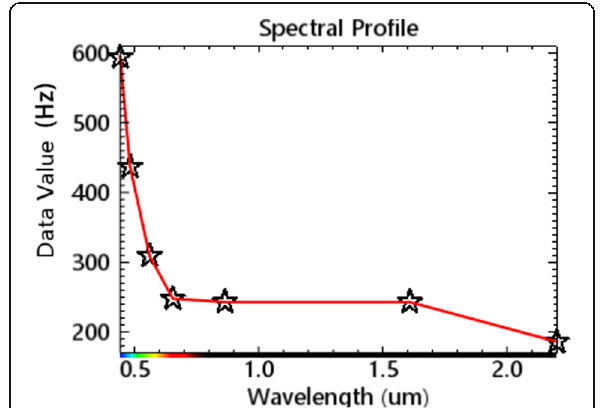
Fig. 7 Chlorophyll-a absorption spectrum